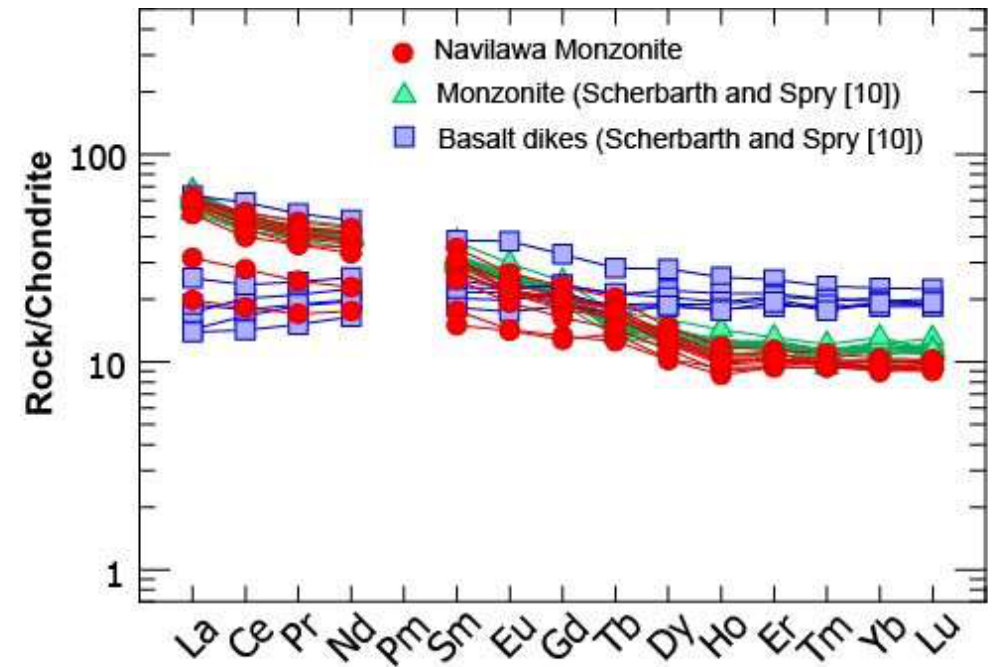
Figure 6. Chondrite-normalized REE patterns of the Navilawa Monzonite and basaltic–andesite dikes from the Tuvatu prospect. Data from the Navilawa Monzonite and basaltic–andesite dikes from the Tuvatu prospect taken from Scherbarth and Spry [10]. Normalization values are from Anders and Grevesse [48] and multiplied by 1.36 to maintain consistency with the older ordinary chondrite normalization values.